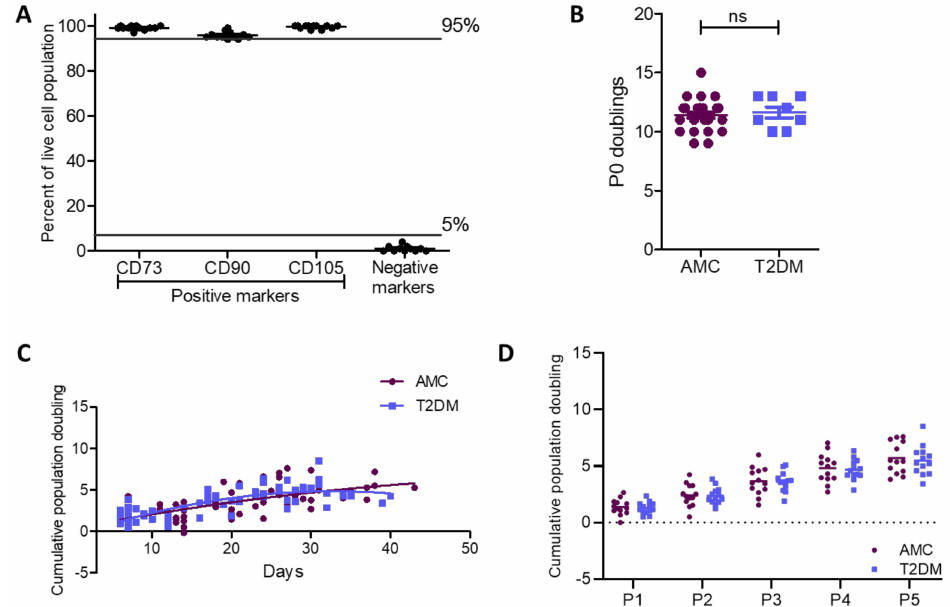
Figure 2. Cell surface phenotype and proliferative capacity were retained in MSCs from donors with T2DM as compared to AMCs. ( A ) Flow cytometry confirmed the population of bone marrow-derived primary cells isolated by plastic adherence as being MSCs due to their positive surface marker expression profile (CD73 + , CD90 + , and CD105 + ) and absence of CD34, CD45, CD11b or CD14, CD19 or CD79 α , and HLA-DR (negative cocktail) expression ( n = 12). ( B ) Population doubling at P0 was una ff ected by the diabetic status of the donor (n = 28 for AMC and n = 8 for T2DM cohorts). ( C ) There was also no di ff erence in doubling capacity between MSCs derived from individuals with T2DM or AMCs when cumulative population doublings per day were compared between the two groups (comparison of second-order polynomial nonlinear regression of the proliferation curve for each cohort of n = 13). ( D ) A 2-way ANOVA determined that there was no e ff ect of T2DM on proliferative capacity per passage (P1–P5). All data are displayed as mean ± SEM. ns = not significant, i.e., p >